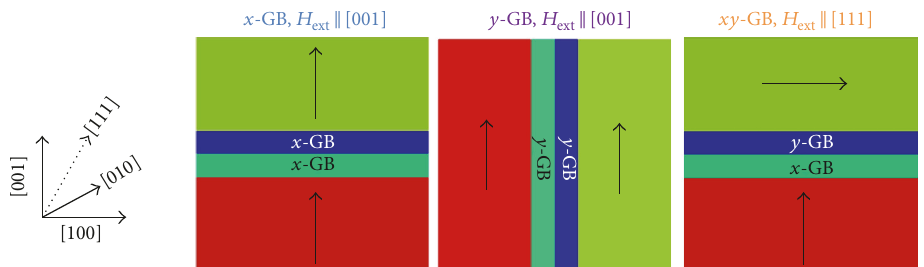
Figure 14: Three different configurations with the orientation of the GB parallel and normal to 𝐻 ext and the 𝑐 -axis of the grain perpendicular to the GB ( 𝑥 -GB) and parallel to the GB ( 𝑦 -GB).